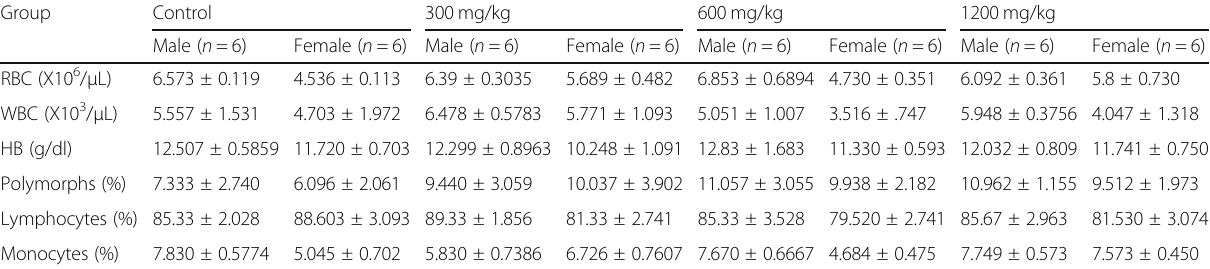
Table 1 Hematological analysis of study subjects . Values are expressed as mean ± SEM Statistical significance (p) calculated by one way ANOVA followed by Newman-Keuls multiple comparison test